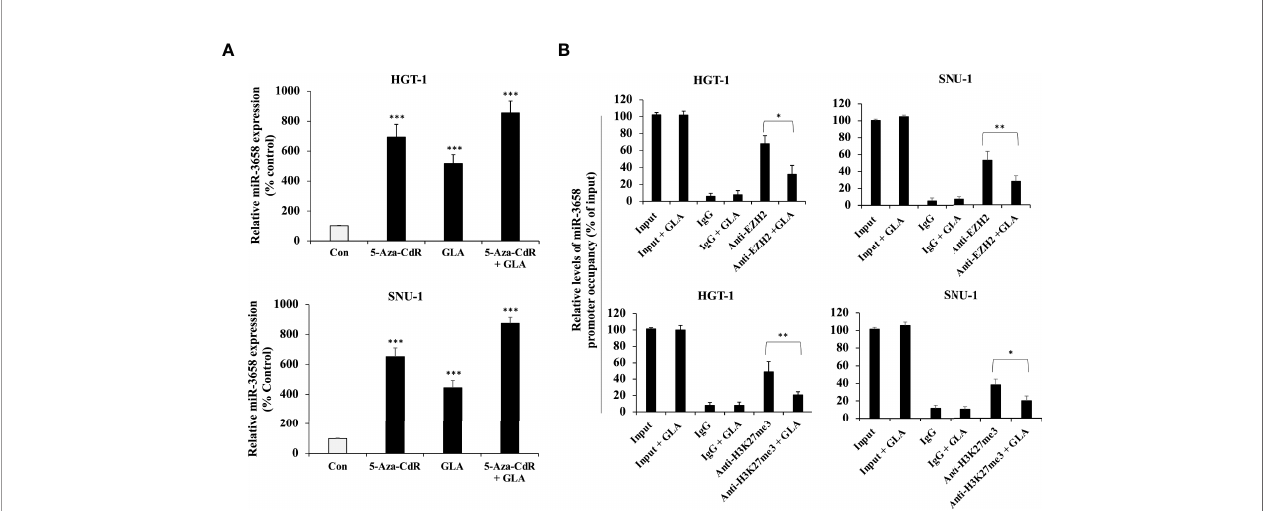
FIGURE 4 | Epigenetic regulation of miR-3658 by GLA. (A) HGT-1 and SNU-1 cells were treated with 5 m mol/L of 5-Aza-CdR for 72 h to induce demethylation in the presence of GLA (10 µM) or in the absence of GLA. (B) CHIP assay for the effect of GLA on the occupancy of EZH2 and histone methylation marker H3K27me3 to the upstream region of miR-3658. The data represented the mean ± SD (n=3). * p < 0.05, ** p < 0.01, *** p < 0.001.